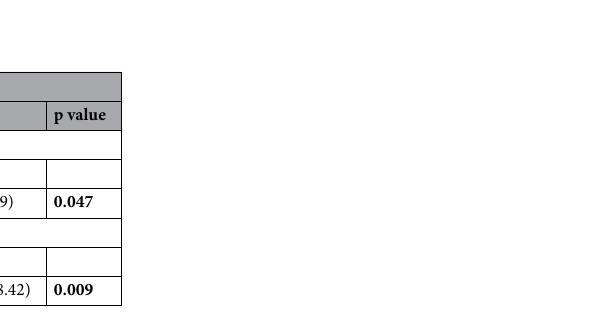
Table 3. Logistic regression for IIb metastasis in the training group. OR, odds ratio; CI, confidence interval. pN pathologic N, cT clinical T, cN clinical N.